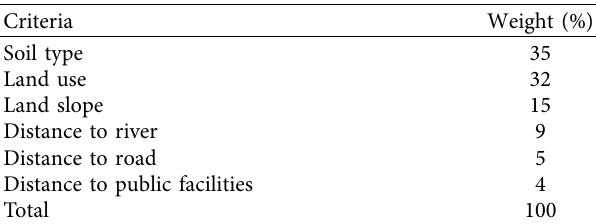
Table 5: The weight of criteria.